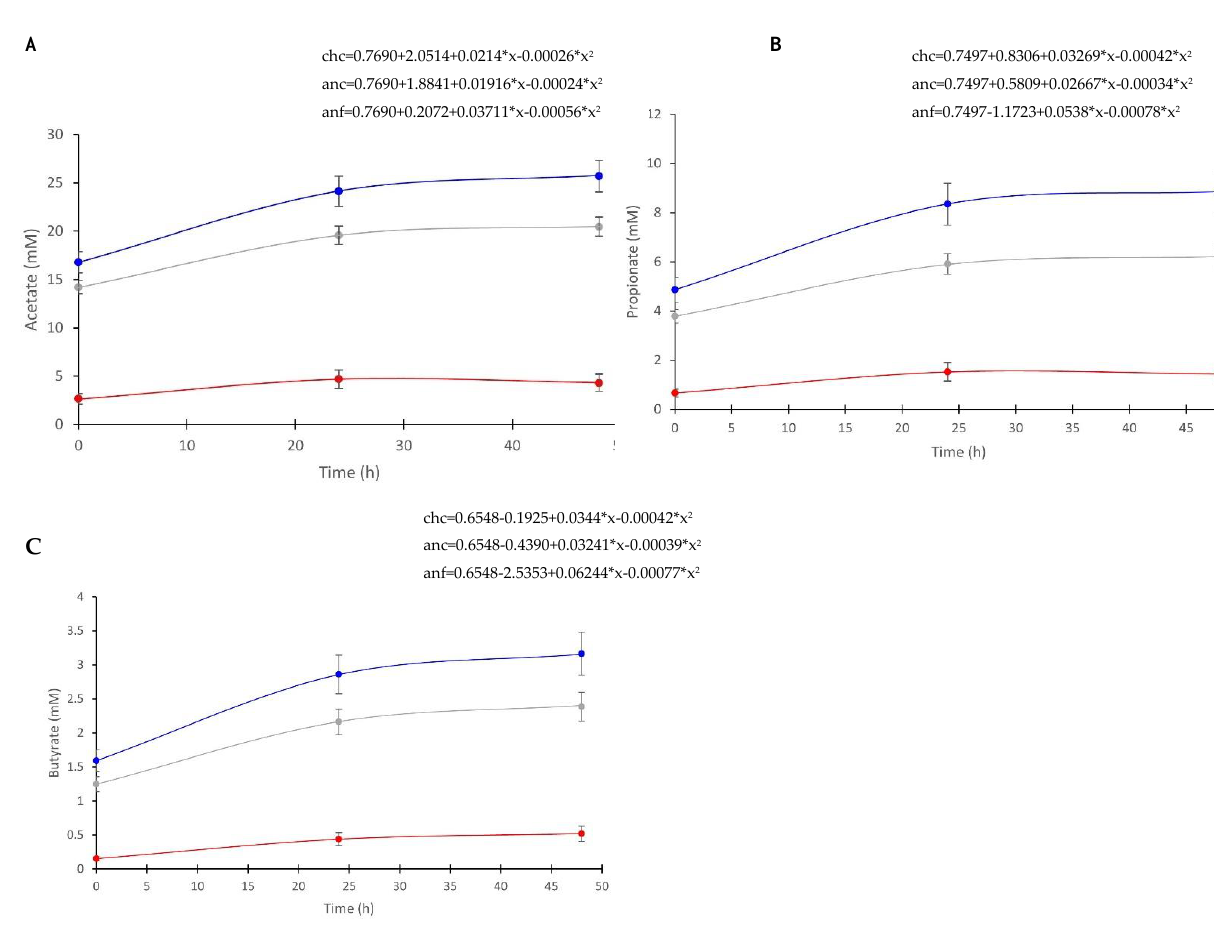
Figure 4. Regression analysis of metabolites. ( A ) Acetate; ( B ) propionate; ( C ) butyrate, as measured by NMR over time in inoculum maintained under different conditions. To inoculate 100 mL vessels maintained in an anaerobic chamber, 100 mL of cecal fluid (anc, n = 15; gray) or 5% fecal slurry (anf, n = 6; red) was used. To inoculate chemostat vessels maintained as batch fermenters (chc, n = 11; blue), 500 mL of cecal fluid was used.